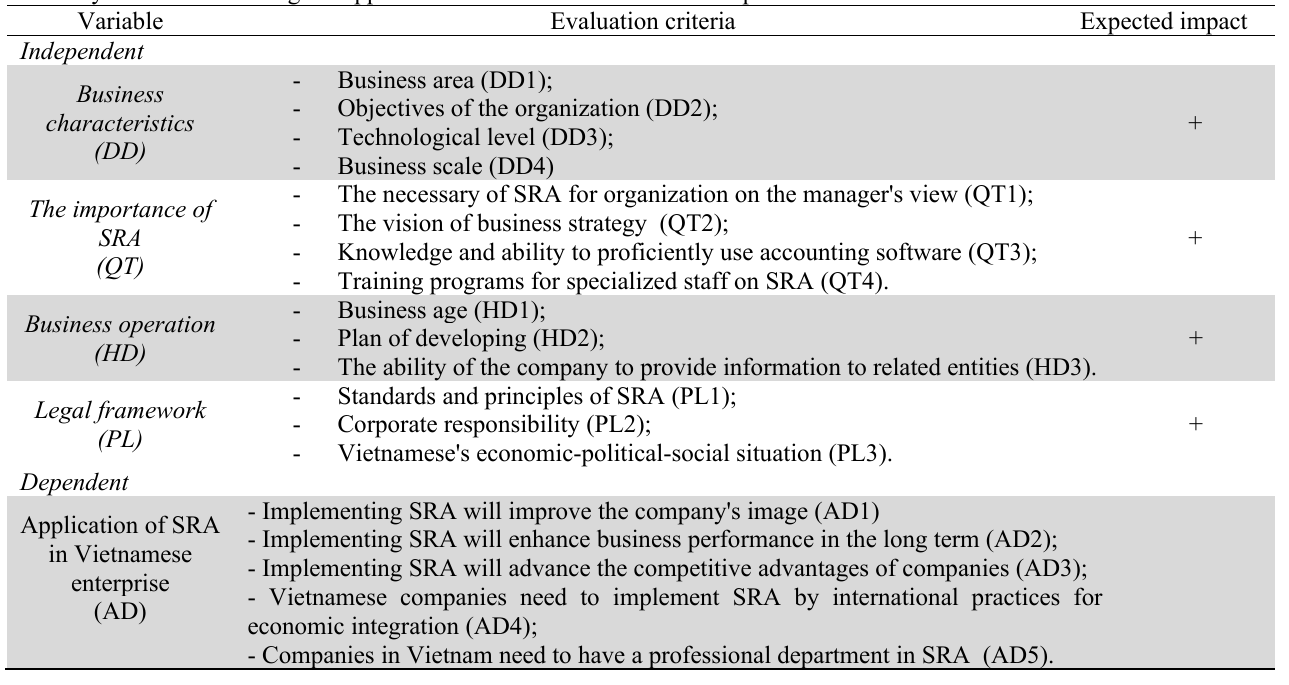
Summary of factors affecting the application of SRA in Vietnamese enterprise Variable Evaluation